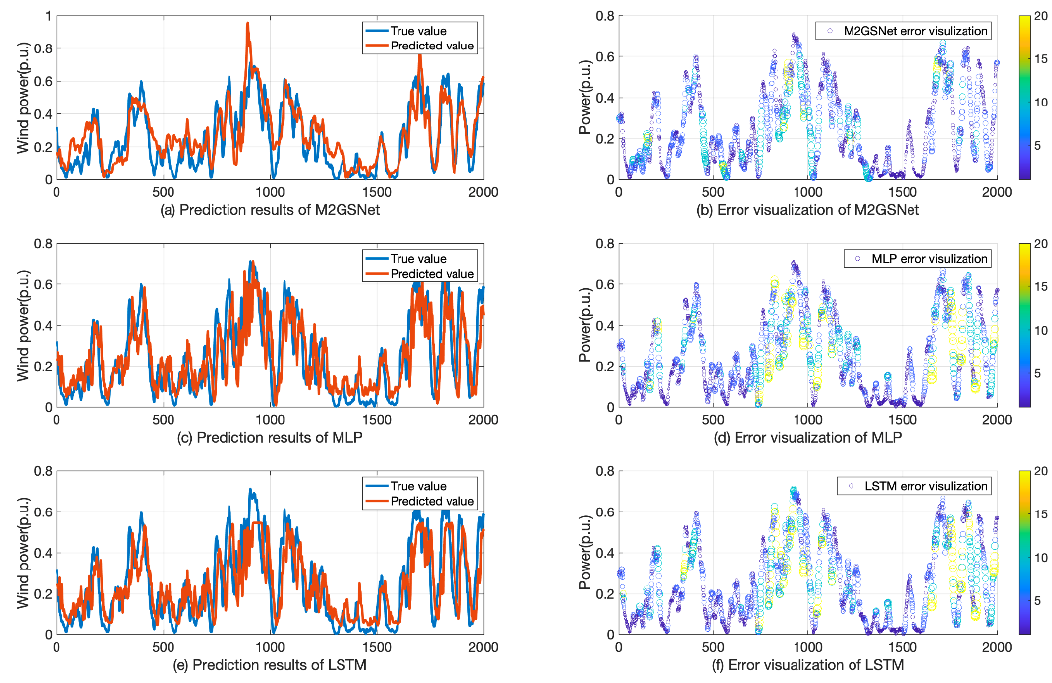
Figure 10. The prediction error analysis.